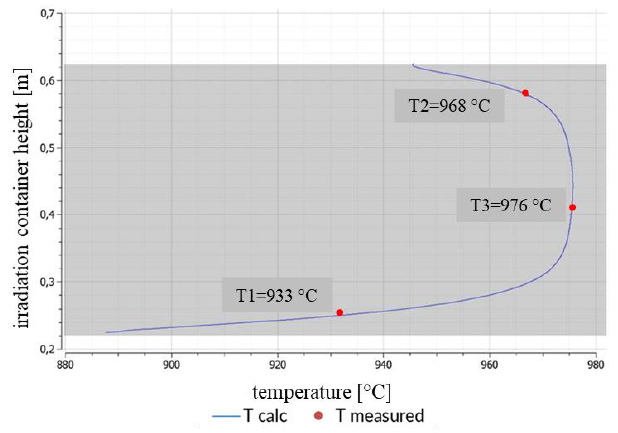
Fig. 8: 3D calculation comparison with temperature